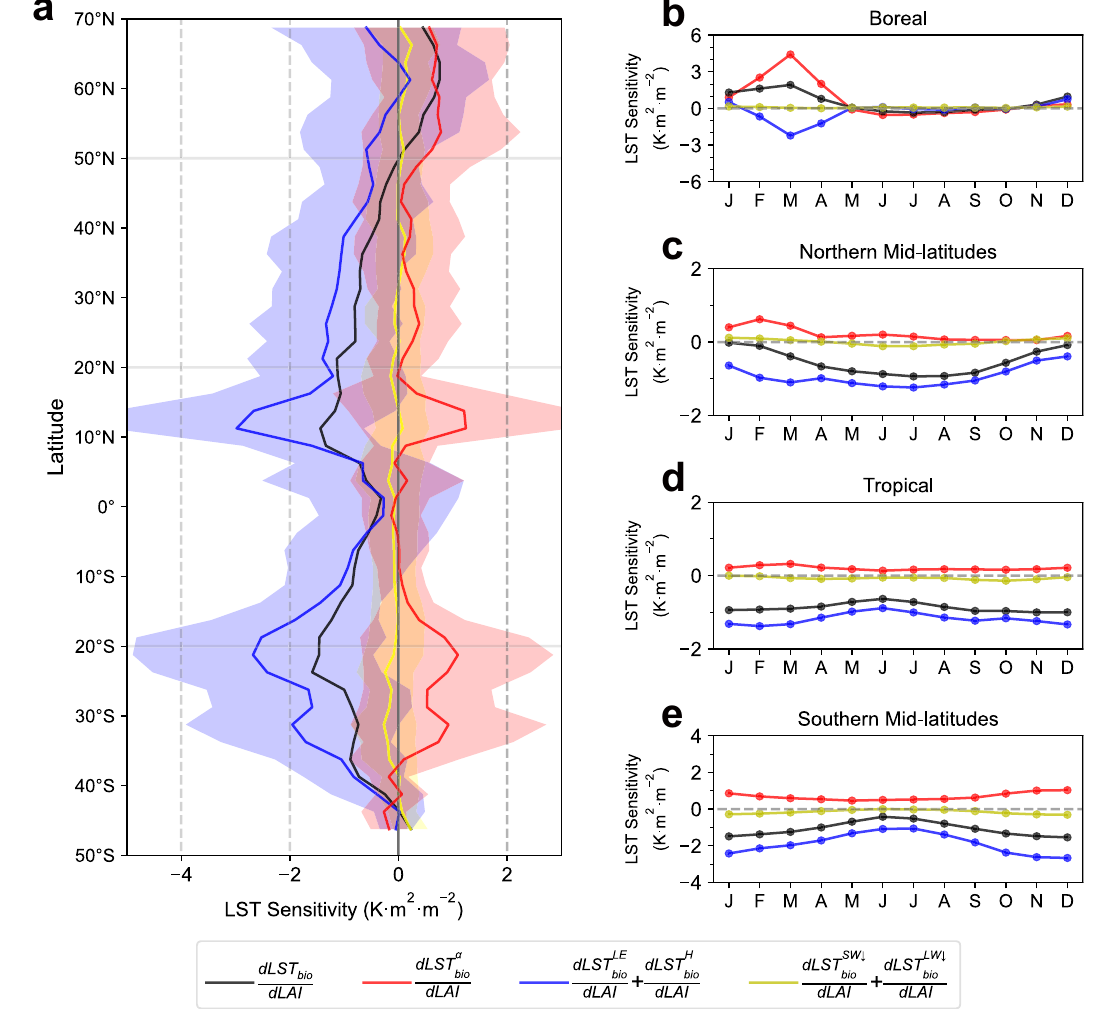
SW # LW # bio dLAI + dLST bio dLAI , yellow line) feedback. The shaded area indicates the latitudinal ( dLST